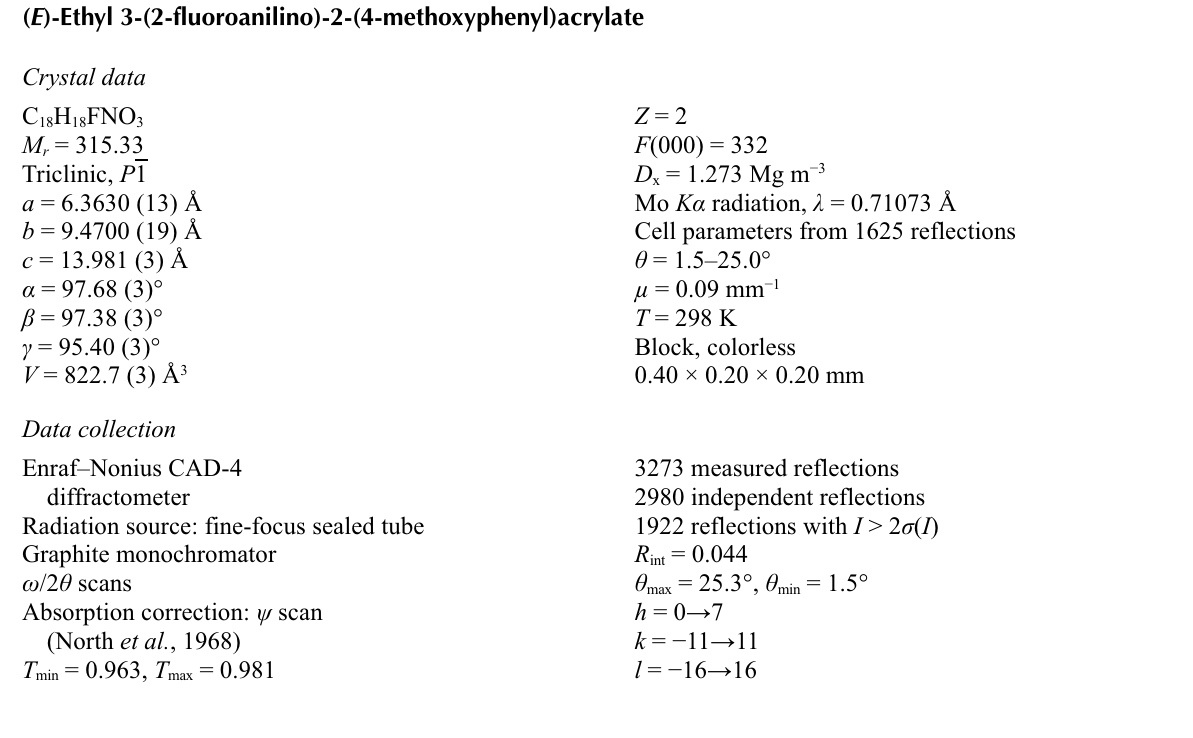
Molecular structure of the title compound, showing the atom-numbering scheme. Displacement ellipsoids are drawn at the 30% probability